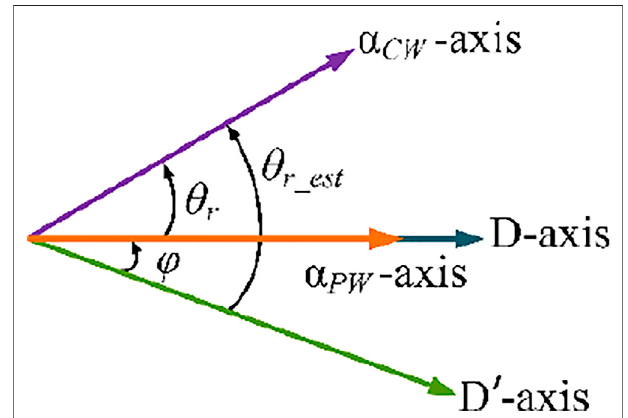
FIGURE 11 | Corresponding fi ctitious frame transformations with the phase axis relationship of BDFRG considering the position error.